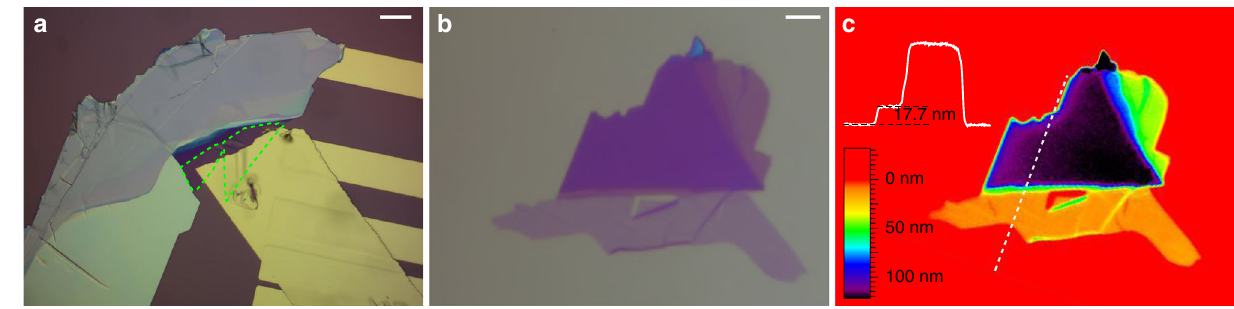
Fig. 2 Fabrication. a Microscopic image of a MoS 2 fi eld-effect transistor device under ×500 magni fi cation. The monolayer is framed within the green dashed line. b , c Microscopic and phase-shift interferometric images of the WS 2 monolayer presented in the main text. The inset in c shows the optical path length difference (OPD) along the white dashed line. The monolayer has an OPD of 17.7 nm, which corresponds to a physical thickness of 0.66 nm. The scale bars in a , b are 20 and 5 μ m, respectively